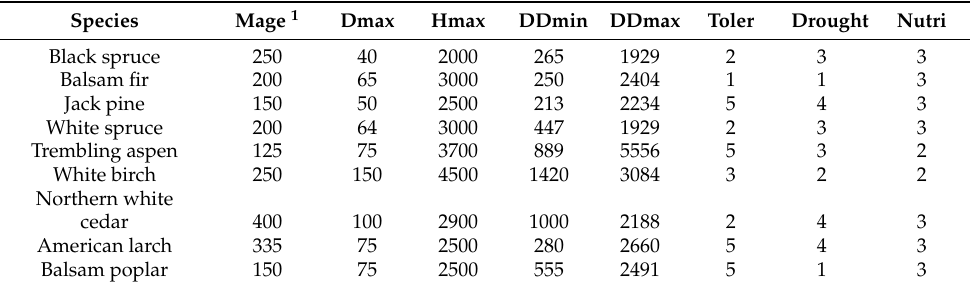
Table 5. Ecological trait database used in the ZELIG-CFS model to simulate forest stand conditions for mixed species forests in northern Ontario,